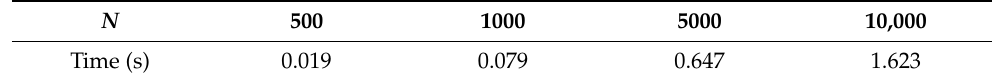
Table 8. Running time of the proposed